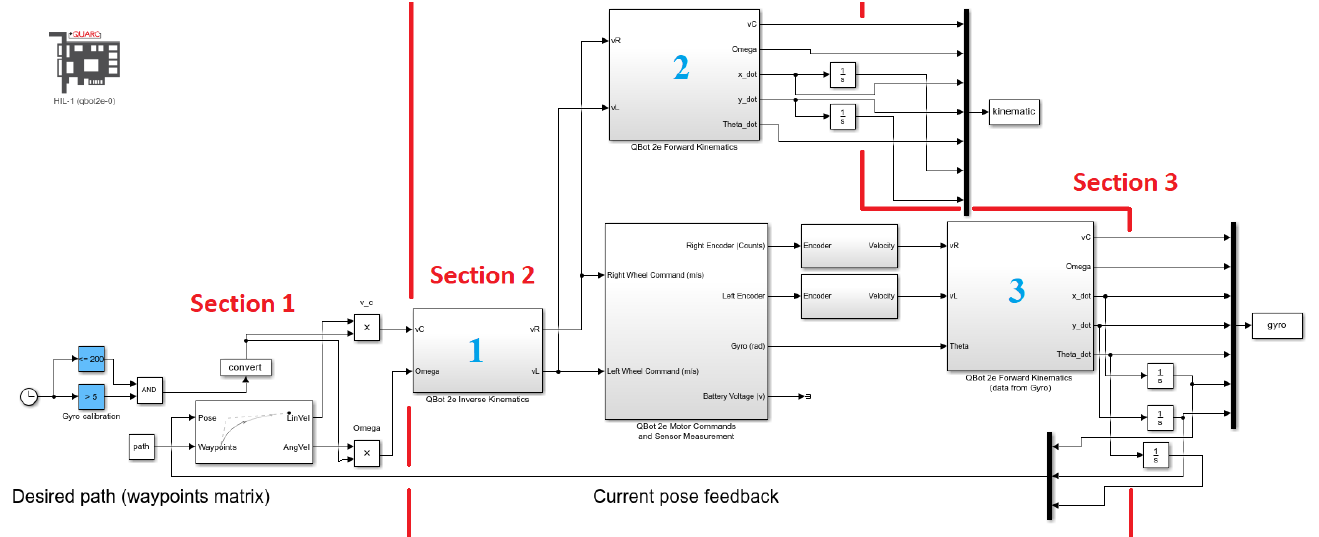
Figure 7. Simulink diagram used in a hardware in the loop simulation to investigate of QBot 2e localization algorithms.